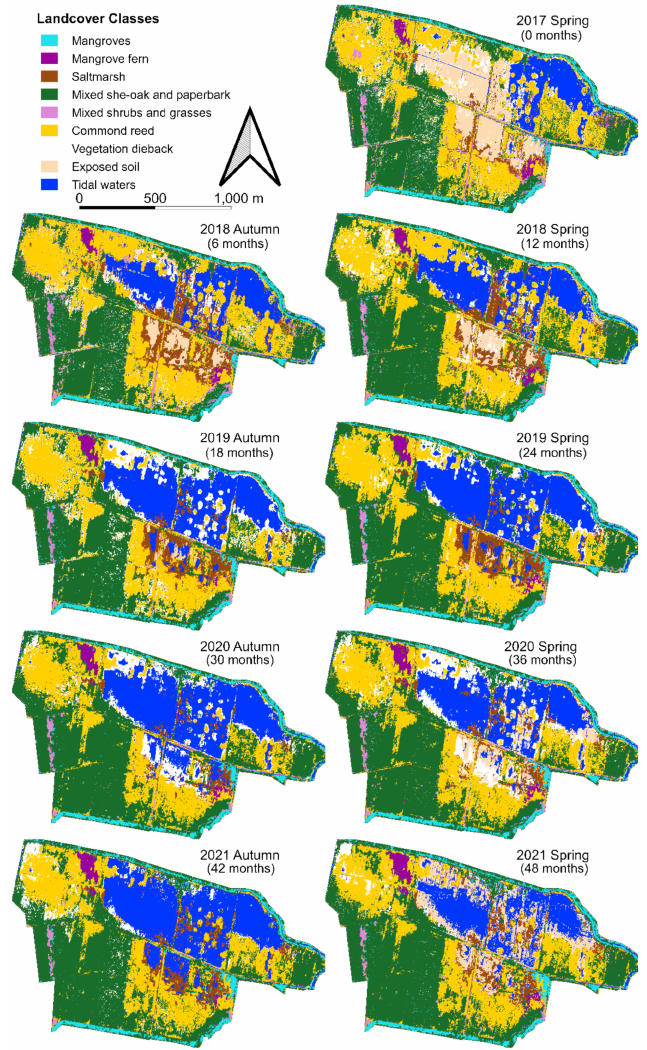
Figure 3. Bi-annual changes in the distribution and cover of land cover classes at Yandina Creek wetland between spring 2017 and